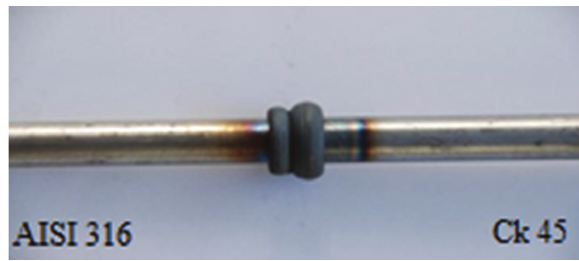
Figure 4: The macroscopic view of welded